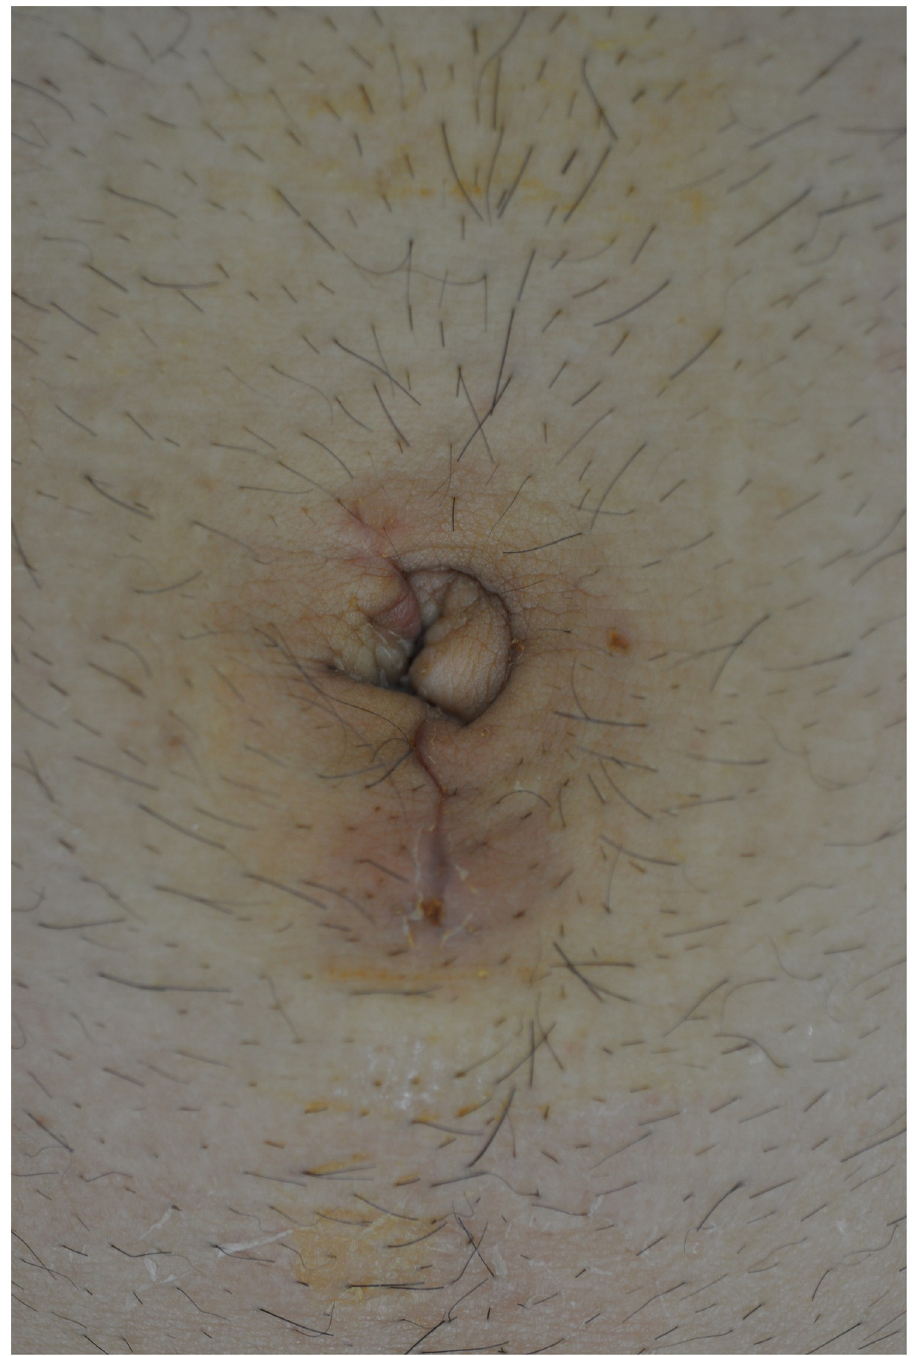
Fig 1. Postoperative scar at 1 week after SILTEP